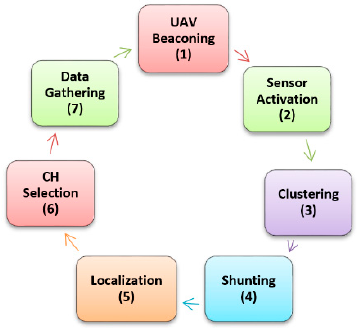
Figure 1. Proposed System lifecycle.